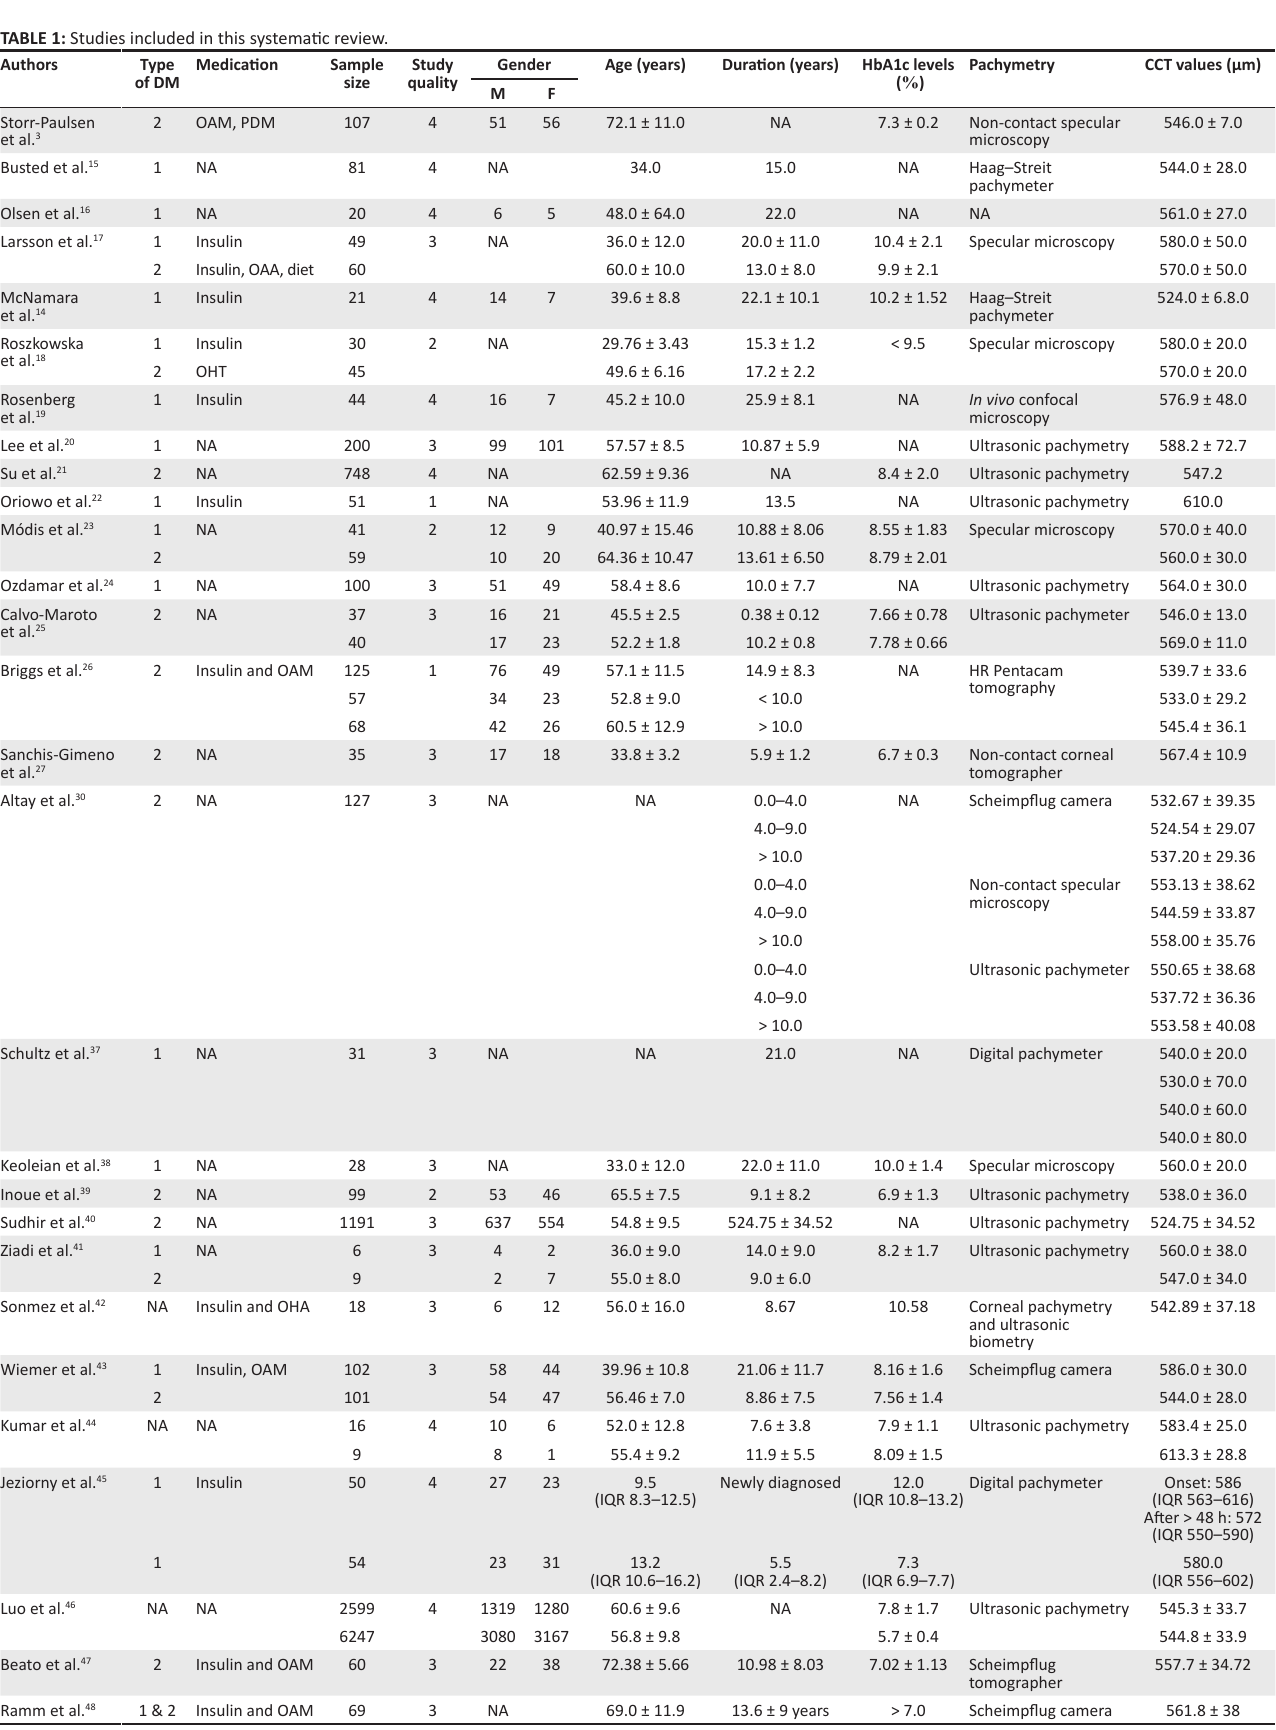
TABLE 1: Studies included in this systematic